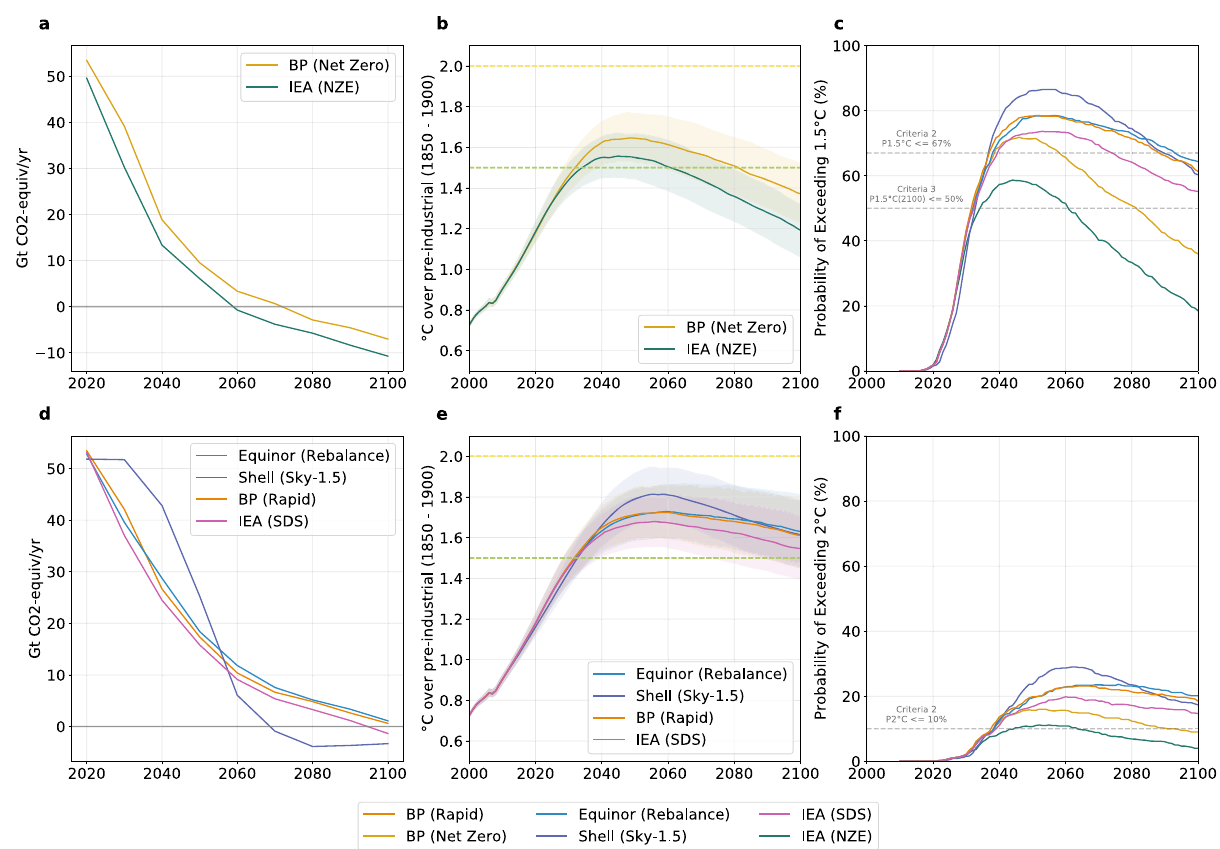
Fig. 3 Assessment of the three criteria for Paris Agreement consistency. a , d Greenhouse gas emissions. b , e Temperature rise above 1850 – 1900 (the solid line is the ensemble median and the shaded plumes are the 33rd – 66th percentile). c Probability of exceeding 1.5 °C. f Probability of exceeding 2 °C. Calculations for ( b , c , e , f ) are performed using MAGICC6.